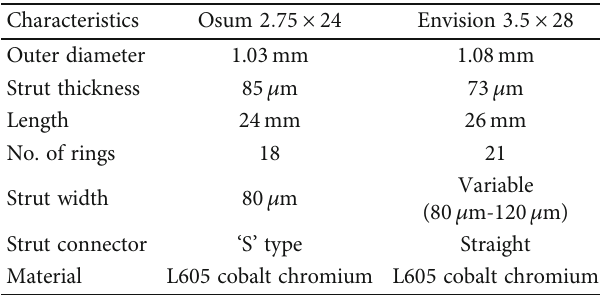
Figure 2: Envision stent, 3 : 5 × 28 (crimped). Table 1: Stent